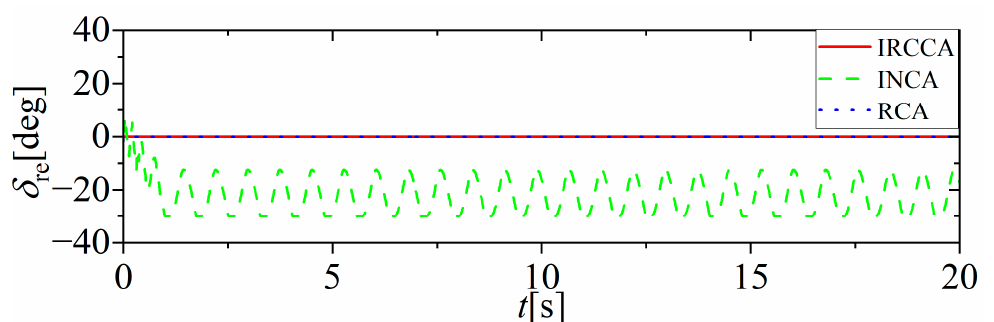
δ deflection. re